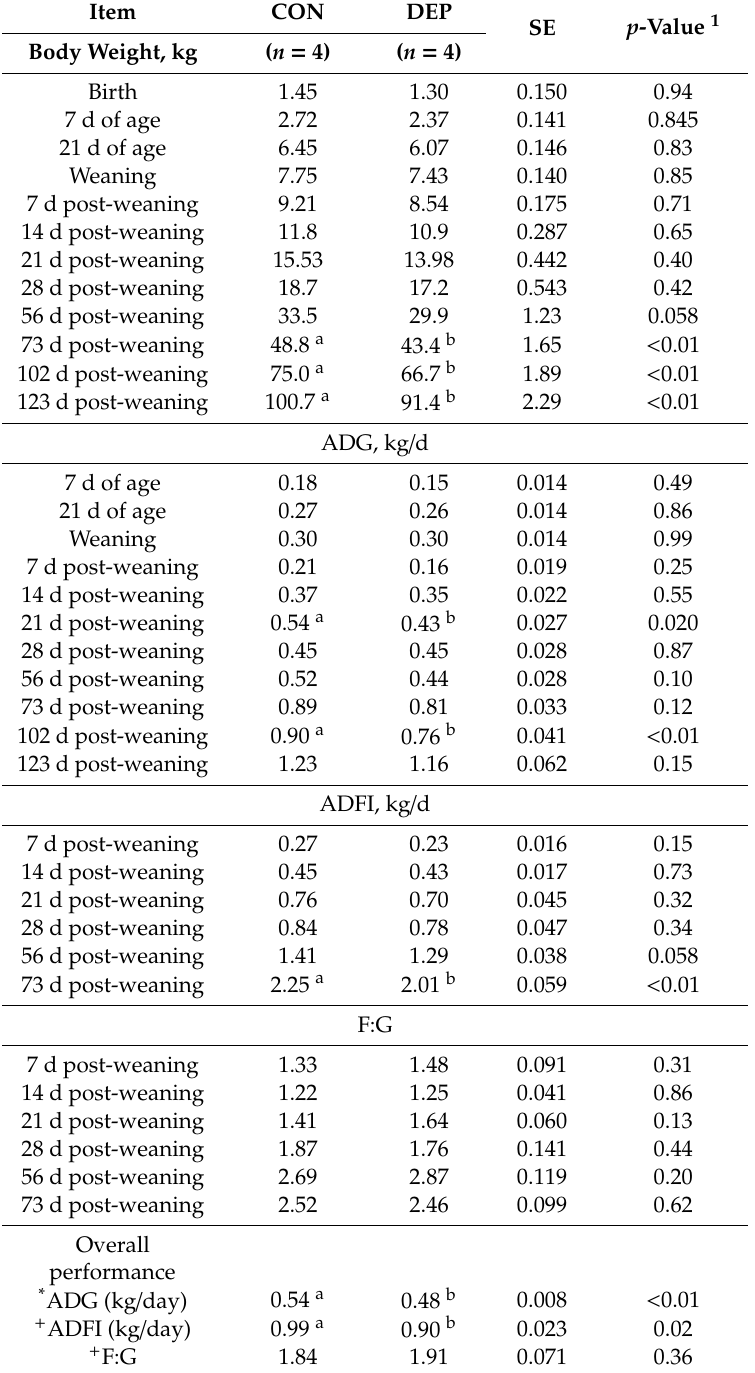
Table 6. Pre and post-weaning performance of piglets with (CON) and without (DEP) access to maternal